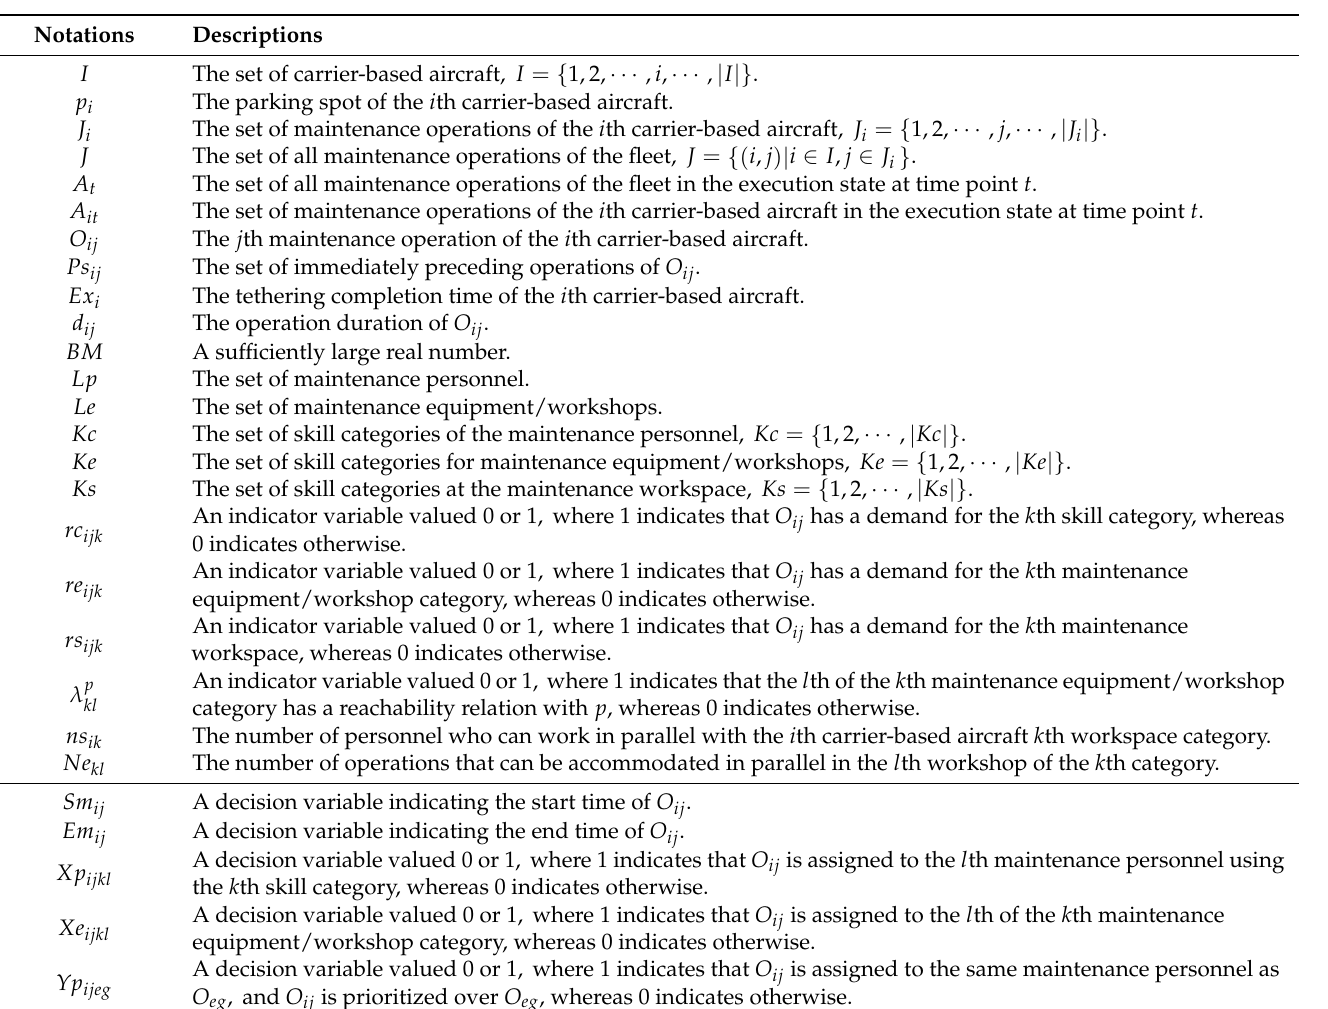
Table 1. Related notations and description of the AMRSP mathematical